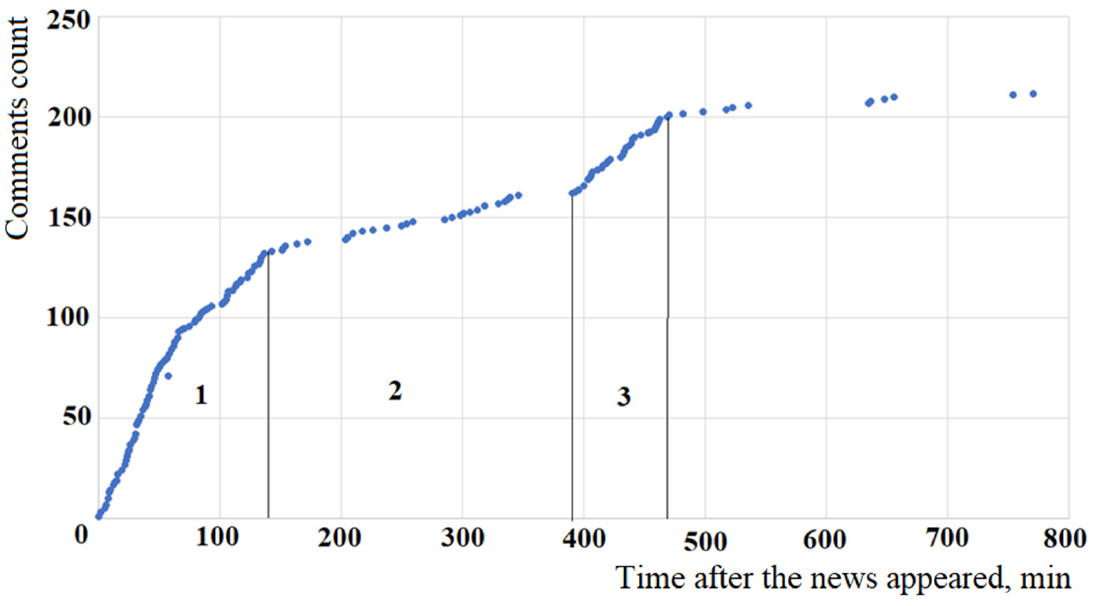
Figure 6. The observed dynamics of change over time, the number of comments on a news item of public interest that appeared on the portal https://echo.msk.ru/news/2626290-echo.html, accessed on 16